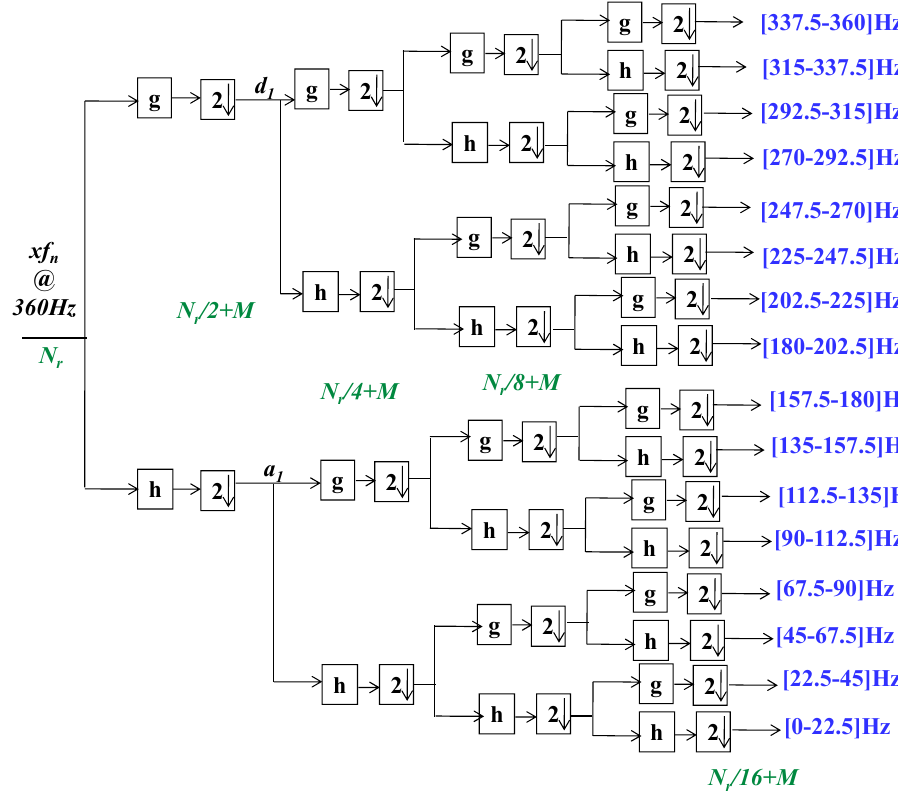
Figure 5. The classical wavelet packet decomposition scheme.